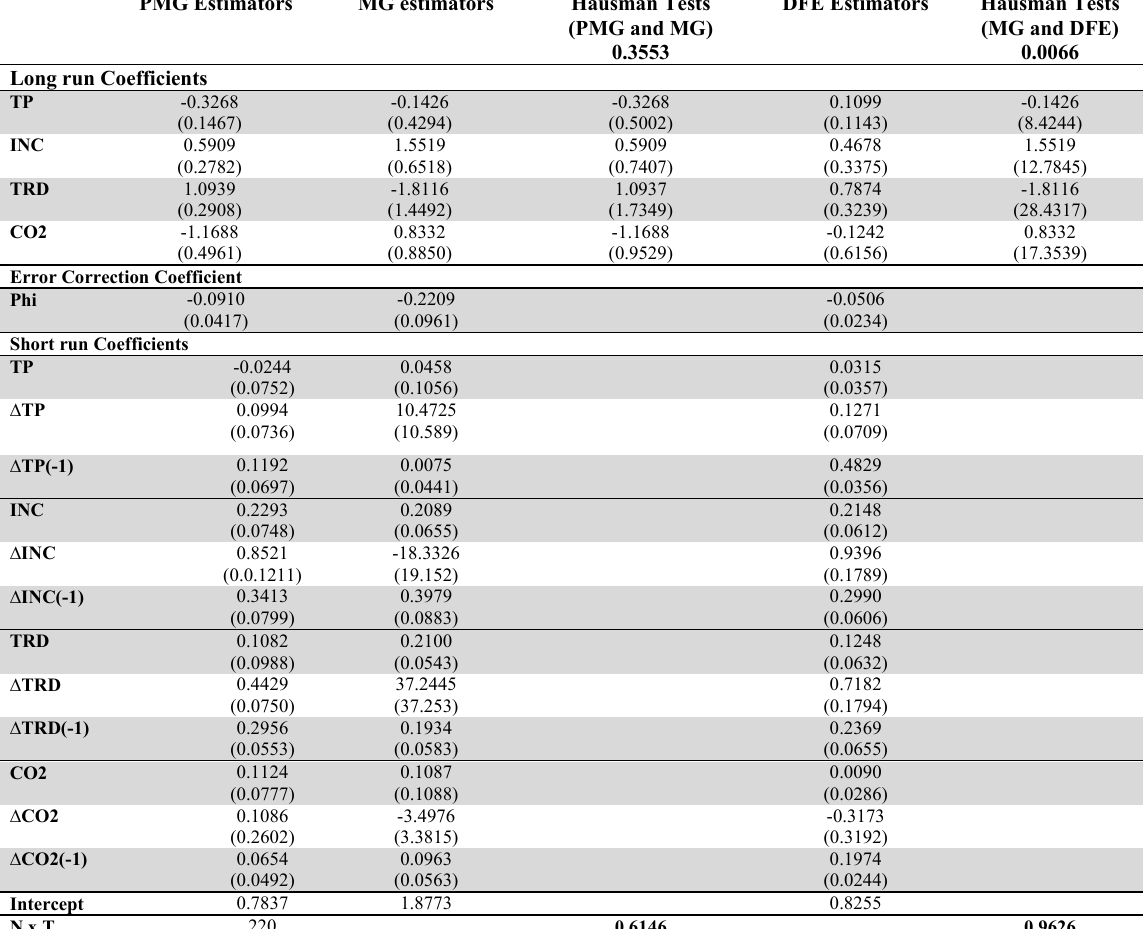
Pooled Estimators for ARDL in ASEAN-5 Countries (1970-2014) Dependent Variable: Tourist